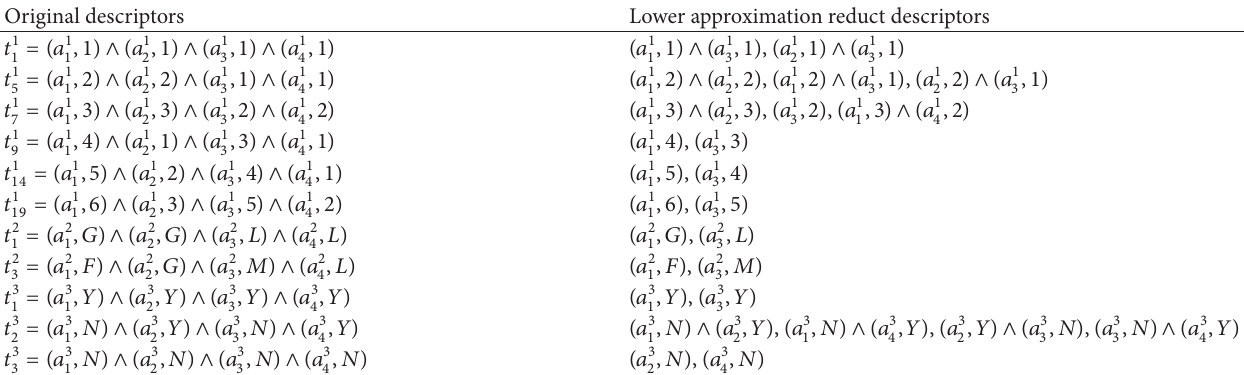
Table 6: Boundary region reduct